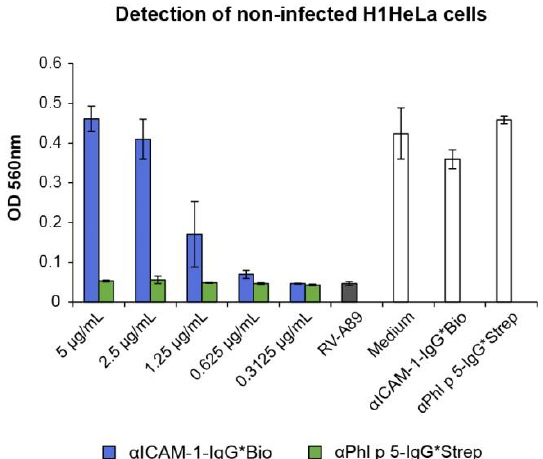
Figure 7. Inhibition of RV infection by αICAM -1-IgG*Bio determined by cell-culture-based neutralization assays. H1HeLa cells were pre-incubated with 2-fold serial dilutions of αICAM -1- IgG*Bio (blue bars) and, for control purposes, with αPhl p5 -IgG*Strep (green bars) or medium. After 3 h, 100 TCID 50 /cell of RV-A89 was added, and cells were incubated for 3 days. Cells incubated with virus only (gray bar; RV-A89), medium only (white bar; medium) or αICAM -1- IgG*Bio and αPhl p5 -IgG*Strep without virus (white bars) served as controls. Remaining cells were stained with crystal violet and OD was read at 560 nm ( y -axis). Data are shown as the mean values of triplicates and are representative of three independent experiments.